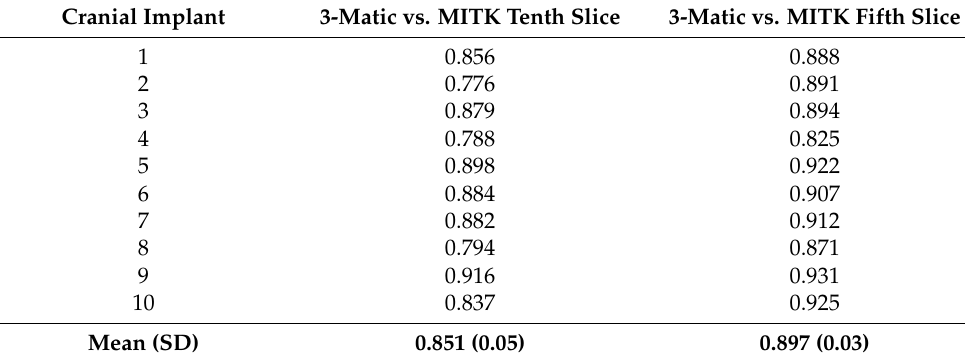
Table 3. Geometric analyses (DSC) of cranial implants. Cranial Implant 3-Matic vs. MITK Tenth Slice 3-Matic vs. MITK Fifth